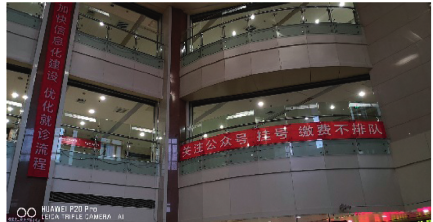
Figure 19: Fire model diagram of floor 4.